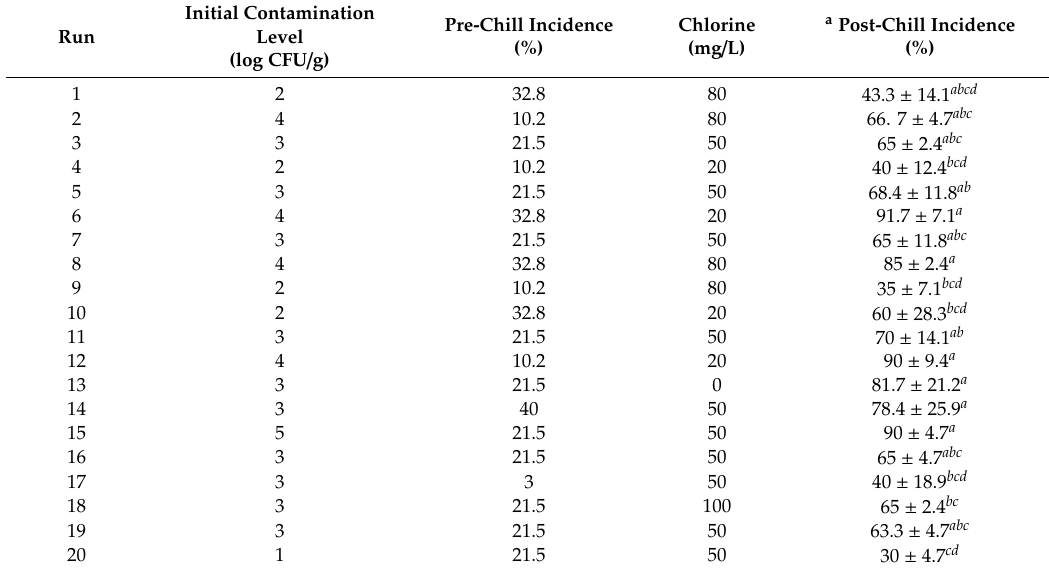
Table 2. Experimental design and post-chill incidence of Salmonella in chilling